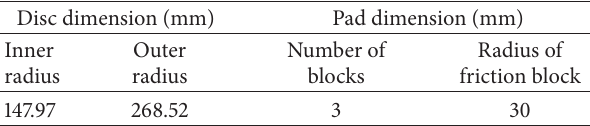
Table 4: Geometric parameters of the block and pad.